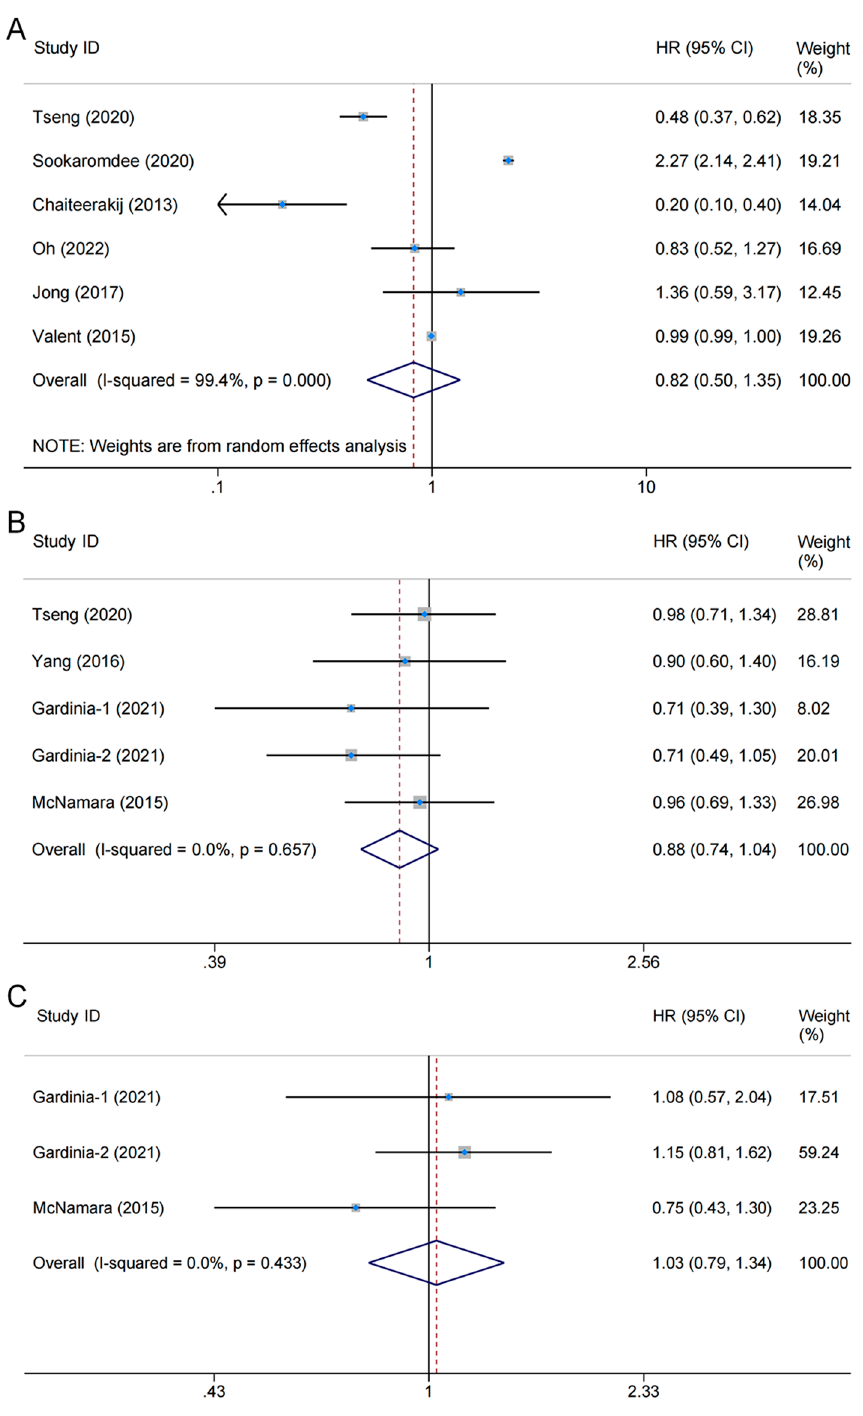
Figure 2. Forest plot of the associations between metformin use and biliary tract cancer: ( A ) risks [21– 23,31,33,34]; ( B ) overall survival [21,24,30,35]; ( C ) disease‑free survival [30,35]. The Study ID column shows the eligible studies included in each endpoint; the HR (95% CI) column is the hazard ratio of the effect of metformin use vs. non‑use on outcomes as reported by the eligible studies; Weight column is the weight percentage of each study in the pooled analysis; and the horizontal axis is the scale of effect estimates. The overall pooled results showed no significant differences in biliary tract cancer risk (HR = 0.82, 95% CI: 0.50–1.35, p = 0.436), overall survival (HR = 0.88, 95% CI: 0.74–1.04, p = 0.135), or disease‑free survival (HR = 1.03, 95% CI: 0.79–1.34, p = 0.829) between metformin users and non‑users. HR: hazard ratio; CI: confidence